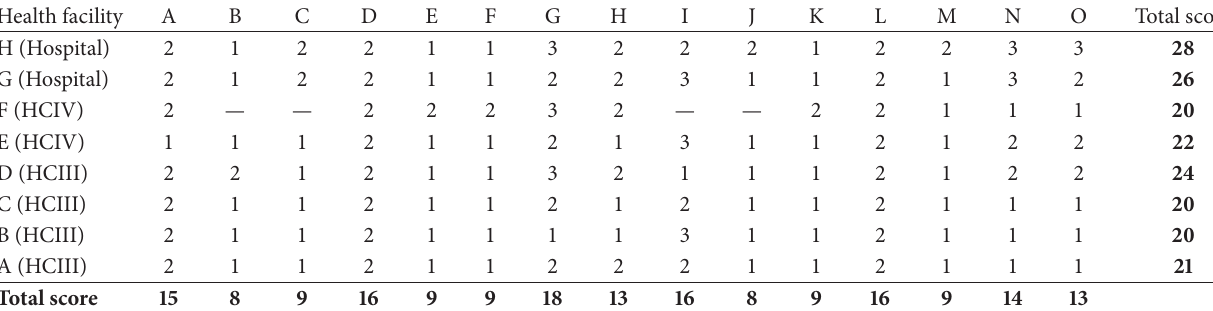
Table 7: General quality performance of Kamuli district health facilities as judged against